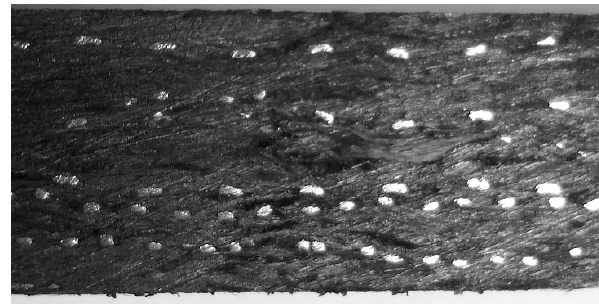
Figure 5. Sectional drawing of layer structure pantograph contact strip.